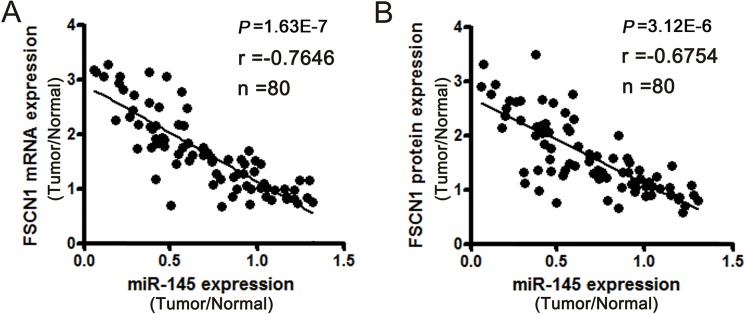
Relative expression of miR-145 and its potential target, FSCN1, in normal/tumor paired samples from patients with gastric cancer.(A) Inverse correlation between miR-145 expression and FSCN1 mRNA levels in normal/tumor paired gastric cancer samples (P = 1.63E-7; Spearman rank correlation test: r = -0.7646; n = 80). (B) Inverse relation between miR-145 expression and FSCN1 protein levels (P = 3.12E-6; r = -0.6754; n = 80).